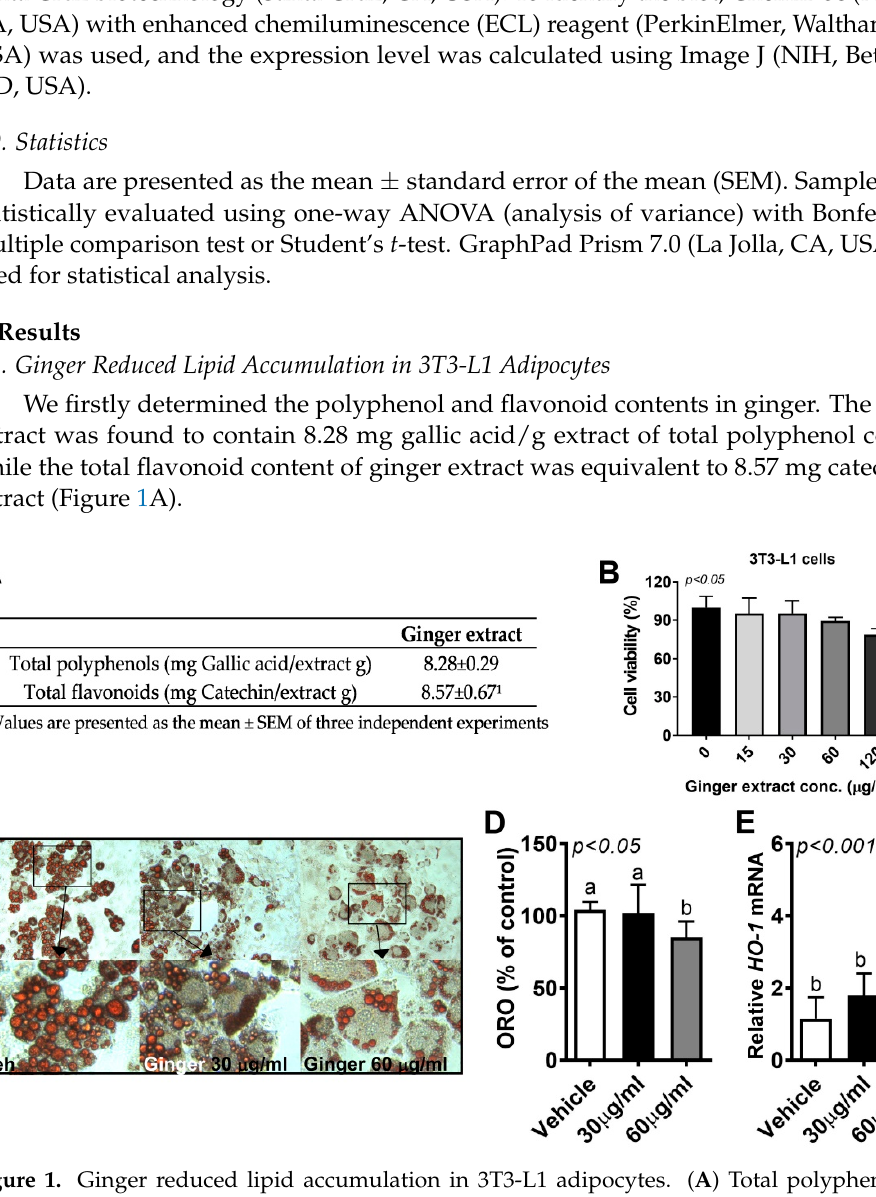
Figure 1. Ginger reduced lipid accumulation in 3T3-L1 adipocytes. ( A ) Total polyphenol and flavonoid contents of ginger extract; the culture of 3T3-L1 cells was incubated with ginger extract at different doses (15–120 μ g/mL). 2,3-Bis-(2-methoxy-4-nitro- 5-sulfophenyl)-2H-tetrazolium-5-carboxanilide salt (XTT) reagent was added for 3 h into 96-well plates to measure cell viability. ( B ) Cell viability by XTT; the 3T3-L1 cells were differentiated in the presence or absence of ginger extract (0–60 μ g/mL) for 7 days. Dimethyl sulfoxide (DMSO) was used as a vehicle control. ( C ) Triglyceride (TG) accumulation in 3T3-L1 adipocytes visualized using Oil Red O (ORO) staining. Representative images from three separate experiments are shown (20× magnification, upper). Images were cropped to the relevant part of the field without altering the resolution (close-cropped images, lower). ( D ) ORO dye was extracted using isopropanol and quantified as the optical density at 500 nm (OD 500 ). ( E ) Heme oxygenase 1 ( HO-1 ) gene expression determined using real-time PCR. Data are represented as the mean ± standard error of the mean (SEM) of three independent experiments. * p < 0.05 (compared with vehicle). Bars with different letters are significantly different according to one-way ANOVA with Bonferroni’s comparison test.